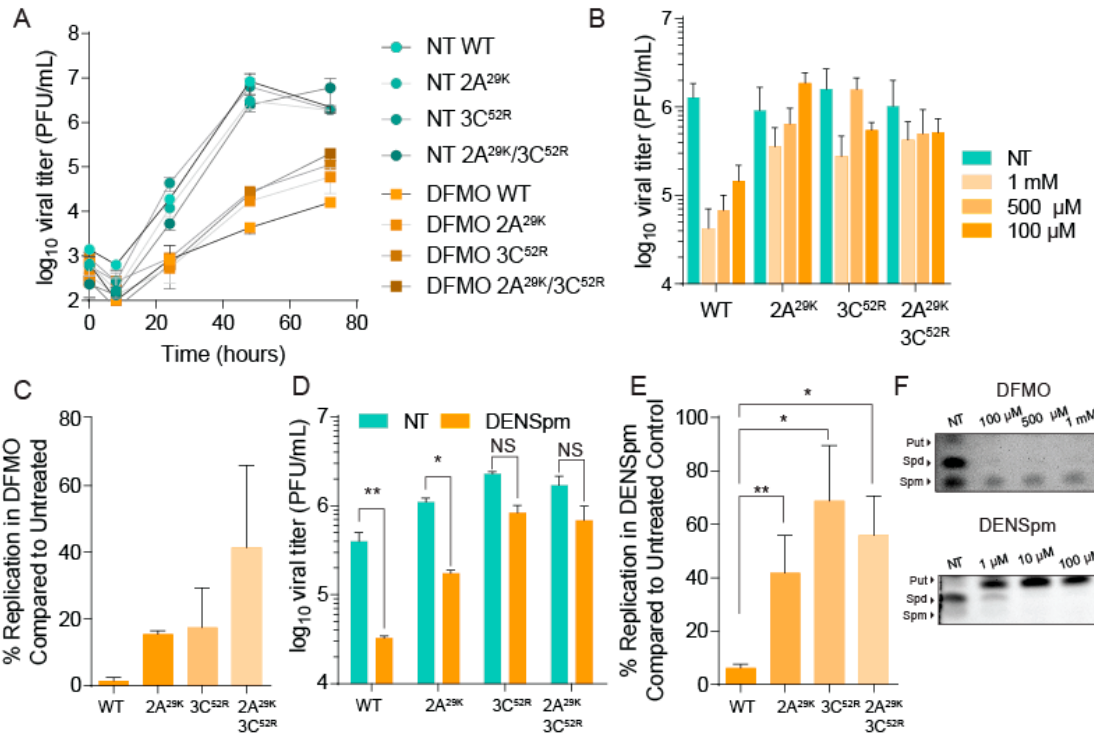
Figure 2. CVB3 mutations in 2A and 3C proteases confer resistance to polyamine depletion. ( A ) Vero cells were left untreated or treated with 500 µ M DFMO for four days prior to infection with CVB3 and 2A and 3C protease mutants. Samples were collected every 24 h and titered via plaque assay. ( B ) Vero cells were treated with increasing doses of DFMO, from 100 µ M to 1 mM, for four days prior to infection with wildtype CVB3 or protease mutants. Viral titers were determined by plaque assay at 48 hpi. ( C ) Viral titers from ( A ) were used to calculate the percent replication in DFMO, by dividing the titer of the virus after infection of DFMO-treated cells by the titer of the virus after infection of untreated cells at 48 hpi. ( D ) Vero cells were left untreated or treated with 100 µ M DENSpm for 16 h prior to infection with wildtype and mutant CVB3 at MOI 0.1. Viral titers were determined by plaque assay at 24 hpi. ( E ) Percent replication was determined as in ( C ) but using titers from ( D ). ( F ) Thin-layer chromatograms resolving the polyamines putrescine (Put), spermidine (Spd) and spermine (Spm) after treatment with DFMO (above) and DENSpm (below). * p ≤ 0.05, ** p ≤ 0.01, *** p ≤ 0.001 using Student’s t -test ( n ≥ 3), comparing treated samples to untreated controls. Error bars represent ± 1